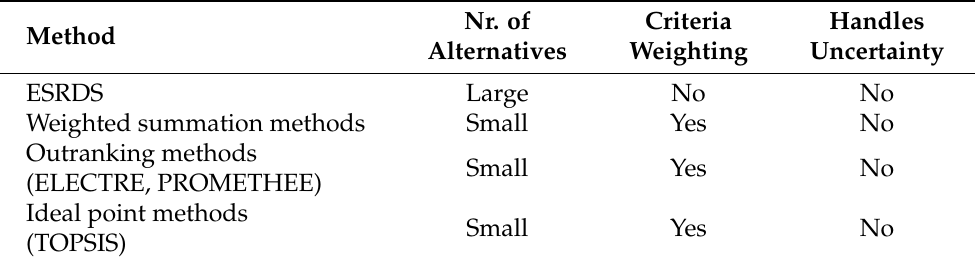
Table 1. Comparison between ESRDS and ranking, ideal point, and weighted summation methods used in